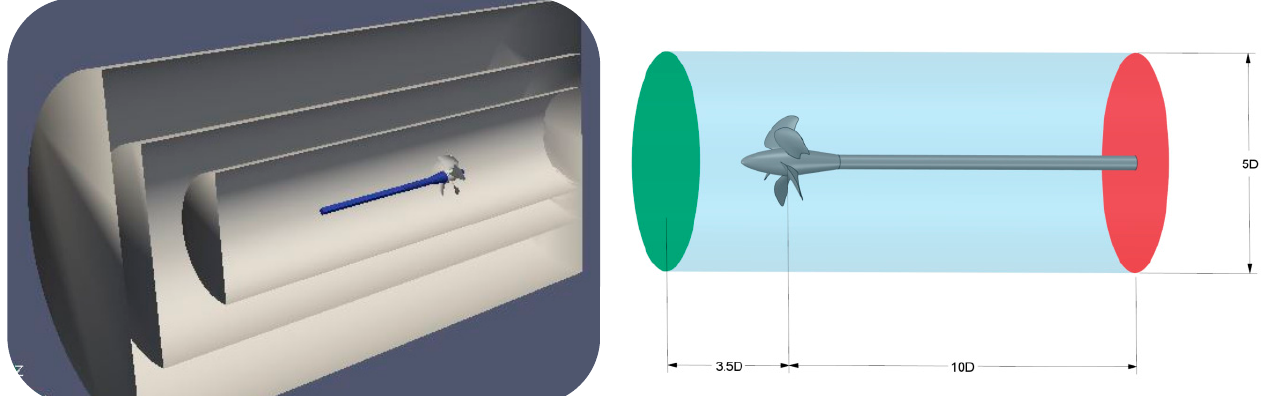
Figure 1. Numerical solution domain used for computational fluid dynamics (CFD) part of the present study.